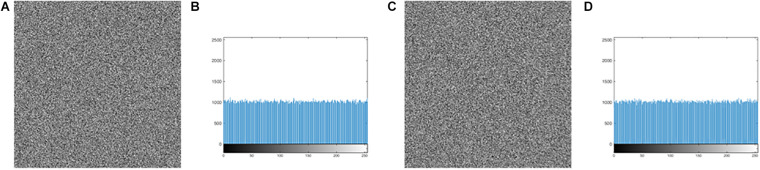
The encrypted image and histogram of “pure white” image and “pure black” image: (A) The encrypted image of “pure white.” (B) The histogram of (A). (C) The encrypted image of “pure black.” (D) The histogram of (C).